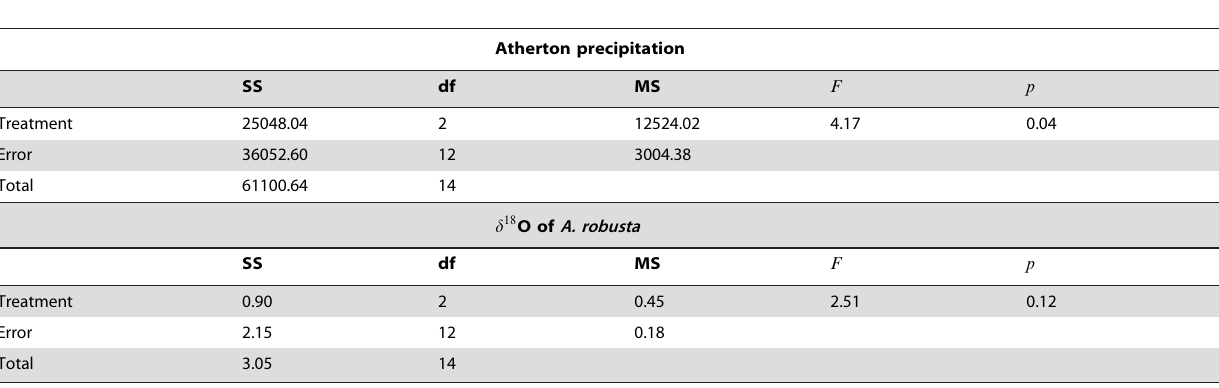
Table 4. Type (I) ANOVAs: Atherton precipitation and d 18 O of A. robusta , for the NINO34 sea surface temperature terciles defined in Table